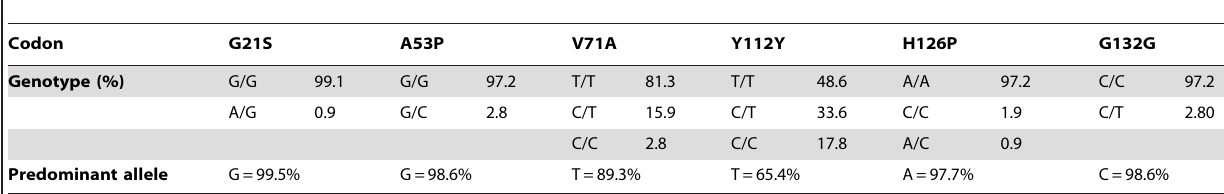
Table 3. Overall frequencies of single nucleotide polymorphisms of sheep SPRN .